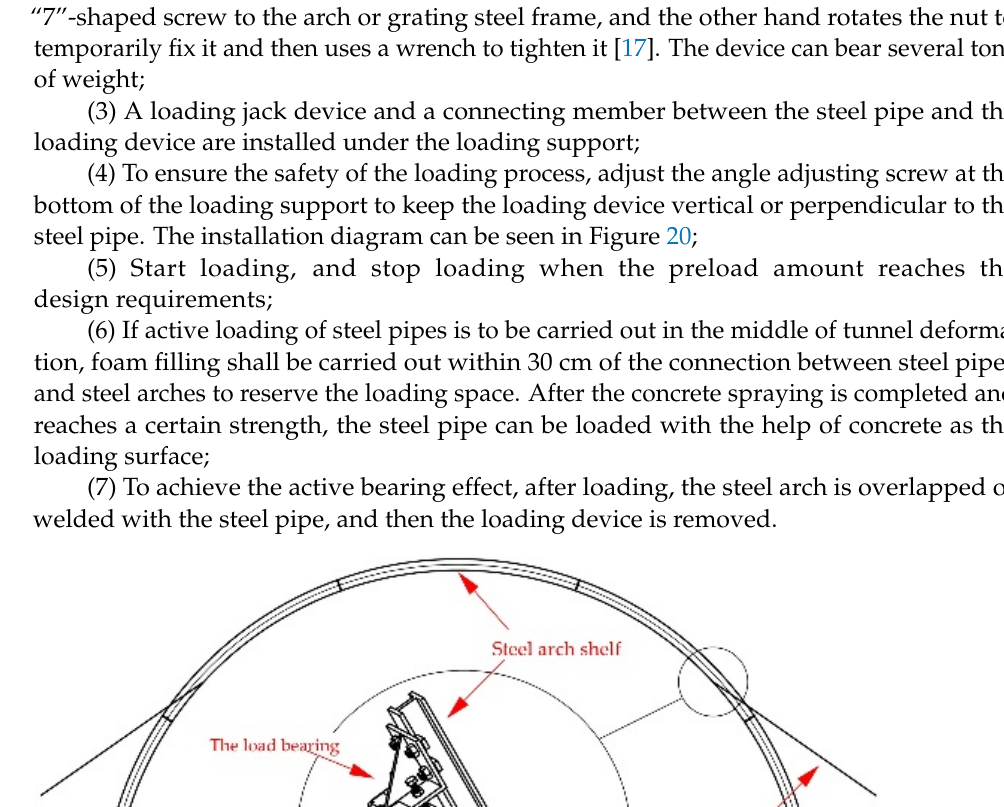
Figure 20. Lapping diagram of loading device.